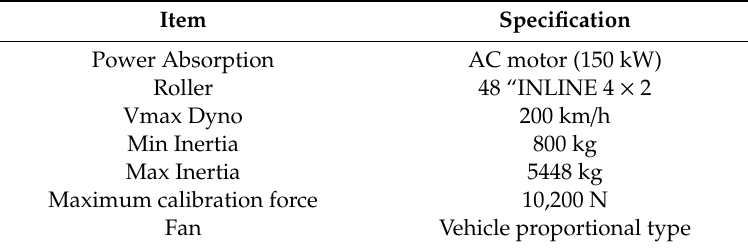
Table 4. Specifications of test dynamometer.